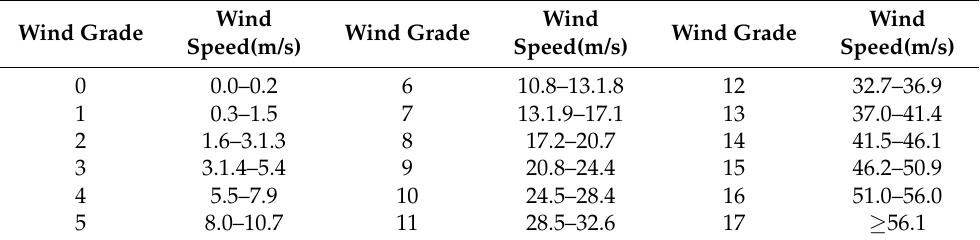
Table 3. Wind grade classification